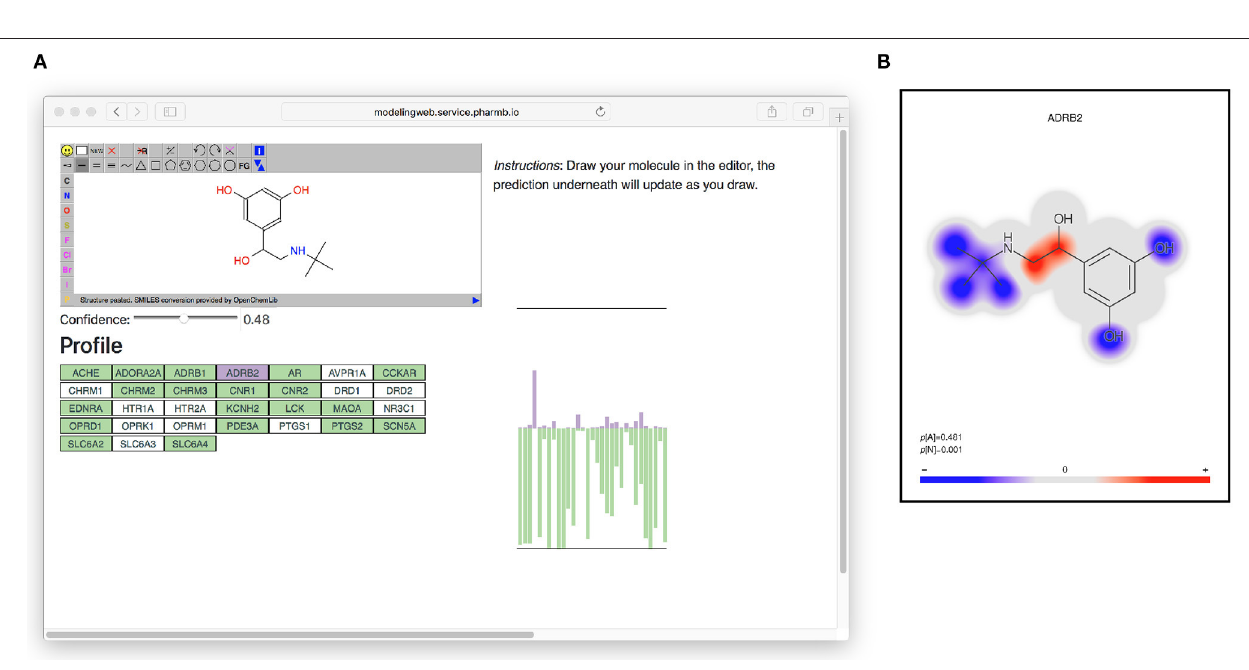
FIGURE 6 | The prediction profile for Terbutaline, a known selective beta-2 adrenergic agonist used as a bronchodilator and tocolytic. (A) The profile as seen on the web page (on the right hand in the figure). To show the profile, the user draws a molecule and selects a confidence level, whereafter the profile will update underneath. The profile is shown as a bar plot with two bars for each target: A purple bar, pointing in the upward direction, indicating the size of the p -value of the “Active” label, and a green bar, pointing downwards, indicating the size of the p -value for the “Non-active” label. (B) Coloring of which parts of the molecule contributed the most to the prediction for ADBR2. Red color indicates the centers of molecular fragments (of height 1–3) that contributed most to the larger class, while blue color indicates center of fragments contributing most to the smaller class. In this case the larger class is “Active,” which can be seen in the size of the p -values in the bottom left of the figure (p[A] = 0.481 >p[N] =